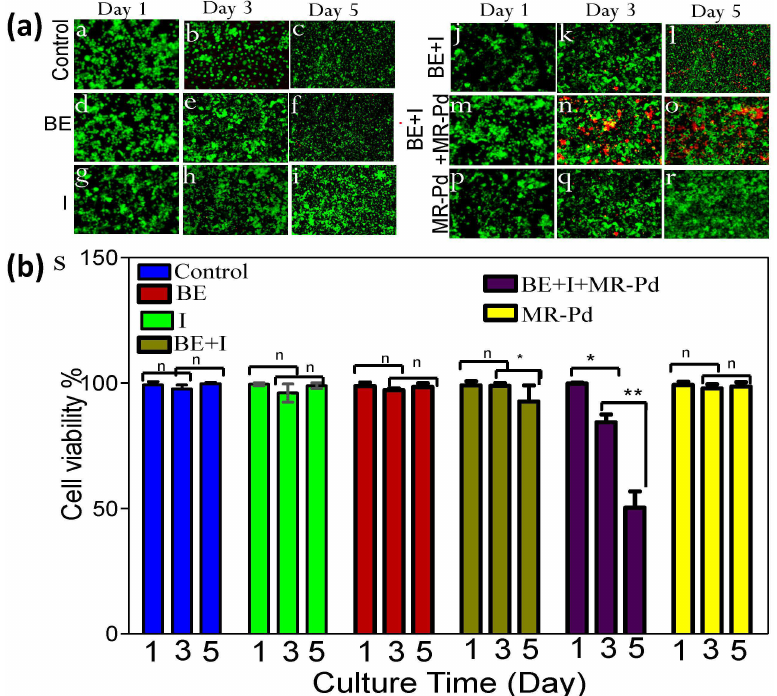
Figure 1. In situ drug synthesis for monolayer PC-3 cells culture model: ( a ) cell viability based on live & dead assay. ( b ) cell viability quantified [BE = Boronic Ester, I = Iodoprazole, MR-Pd = Mesoporous Catalyst]. “*” signifies p ≤ 0.05 (statistically significant), “**” signifies p ≤ 0.01 (highly statistically significant